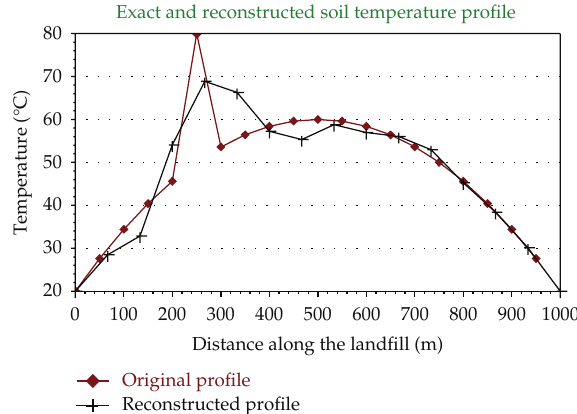
Figure 8: Fifteen intervals—Tikhonov’s regularisation factor-assumed heat transfer coe ffi cient equal to 90% of the value used to generate the simulated data.